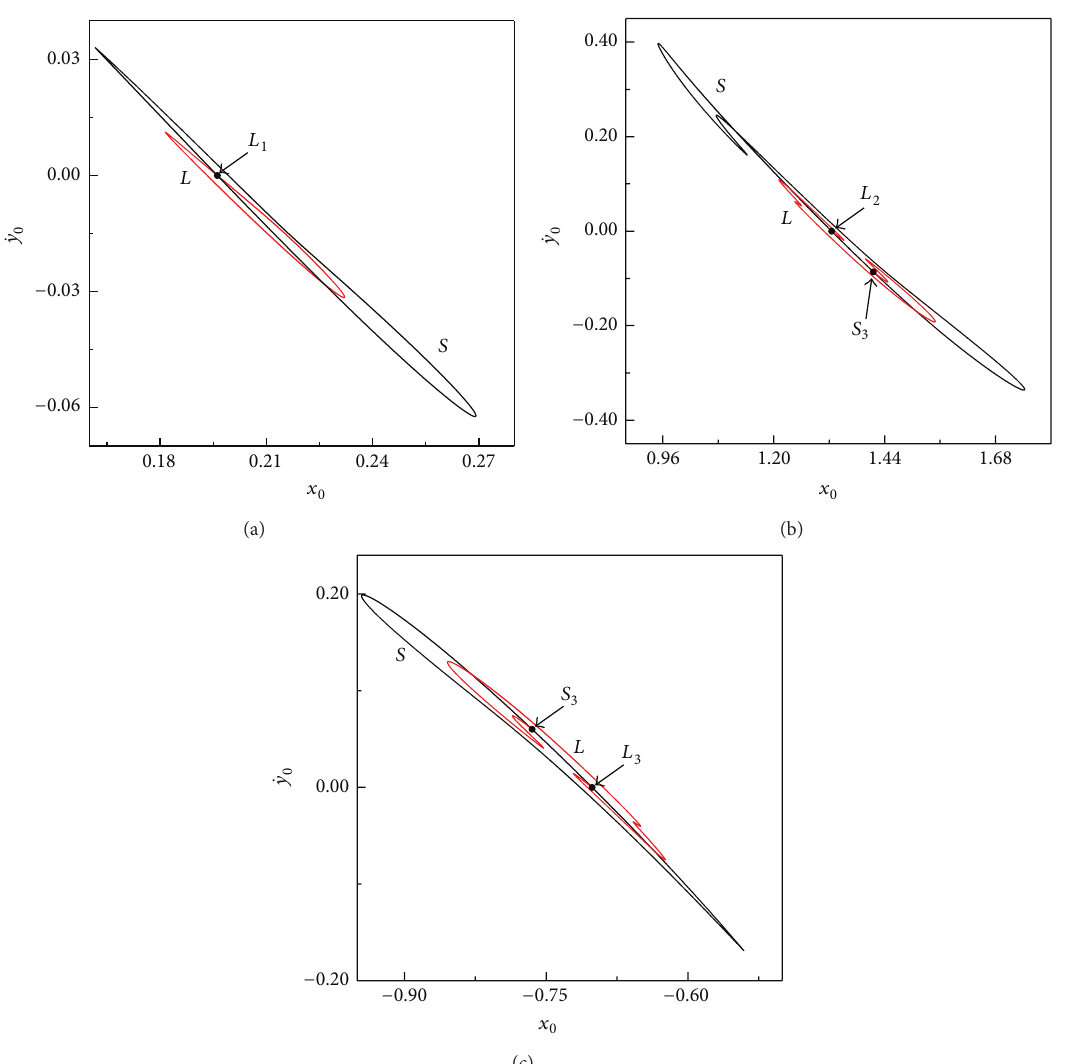
Figure 13: Projections, in the (𝑥 0 , ̇𝑦 0 ) plane, of the characteristic curves of long (red color) and short (black color) period families emanating from the collinear equilibria for 𝜇 = 0 . 2, 𝜔 = 0 . 5 and radiation factors: (a) 𝑞 1 = 0 . 015 and 𝑞 2 = 0 . 05 for 𝐿 1 , (b) 𝑞 1 = 0 . 9 and 𝑞 2 = 0 . 03 for 𝐿 2 , and (c) 𝑞 1 = 0 . 03 and 𝑞 2 = 0 . 9 for 𝐿 3